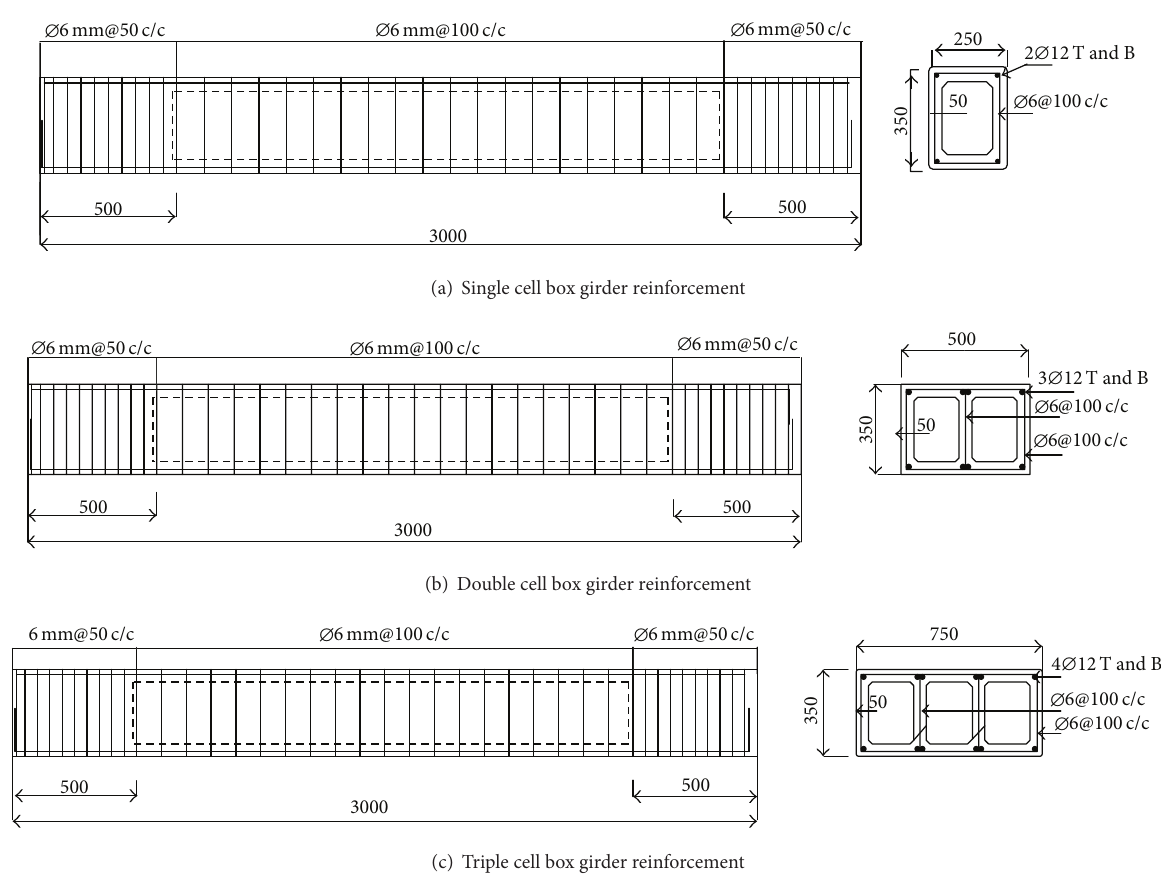
Figure 2: Geometrical detail and reinforcement of girder specimens. (a) Single cell box, (b) double cell box, and (c) triple cell